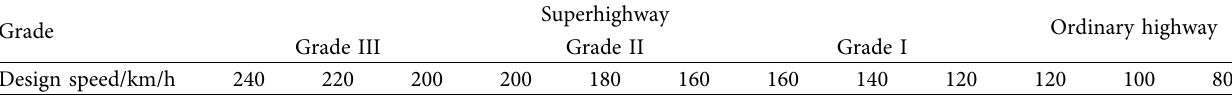
Table 1: Novel classification of highways.